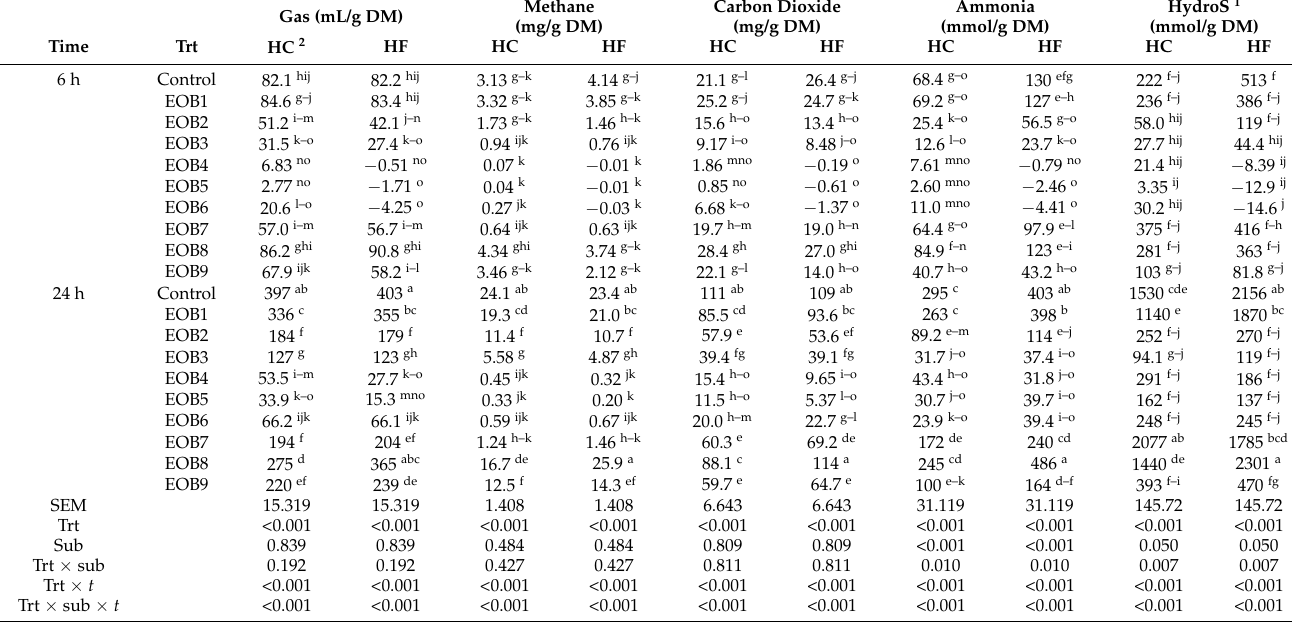
Table 3. Effects of the essential oil blends (EOBs) and time on total gas production, methane, carbon dioxide, ammonia, and hydrogen sulfide ( n =